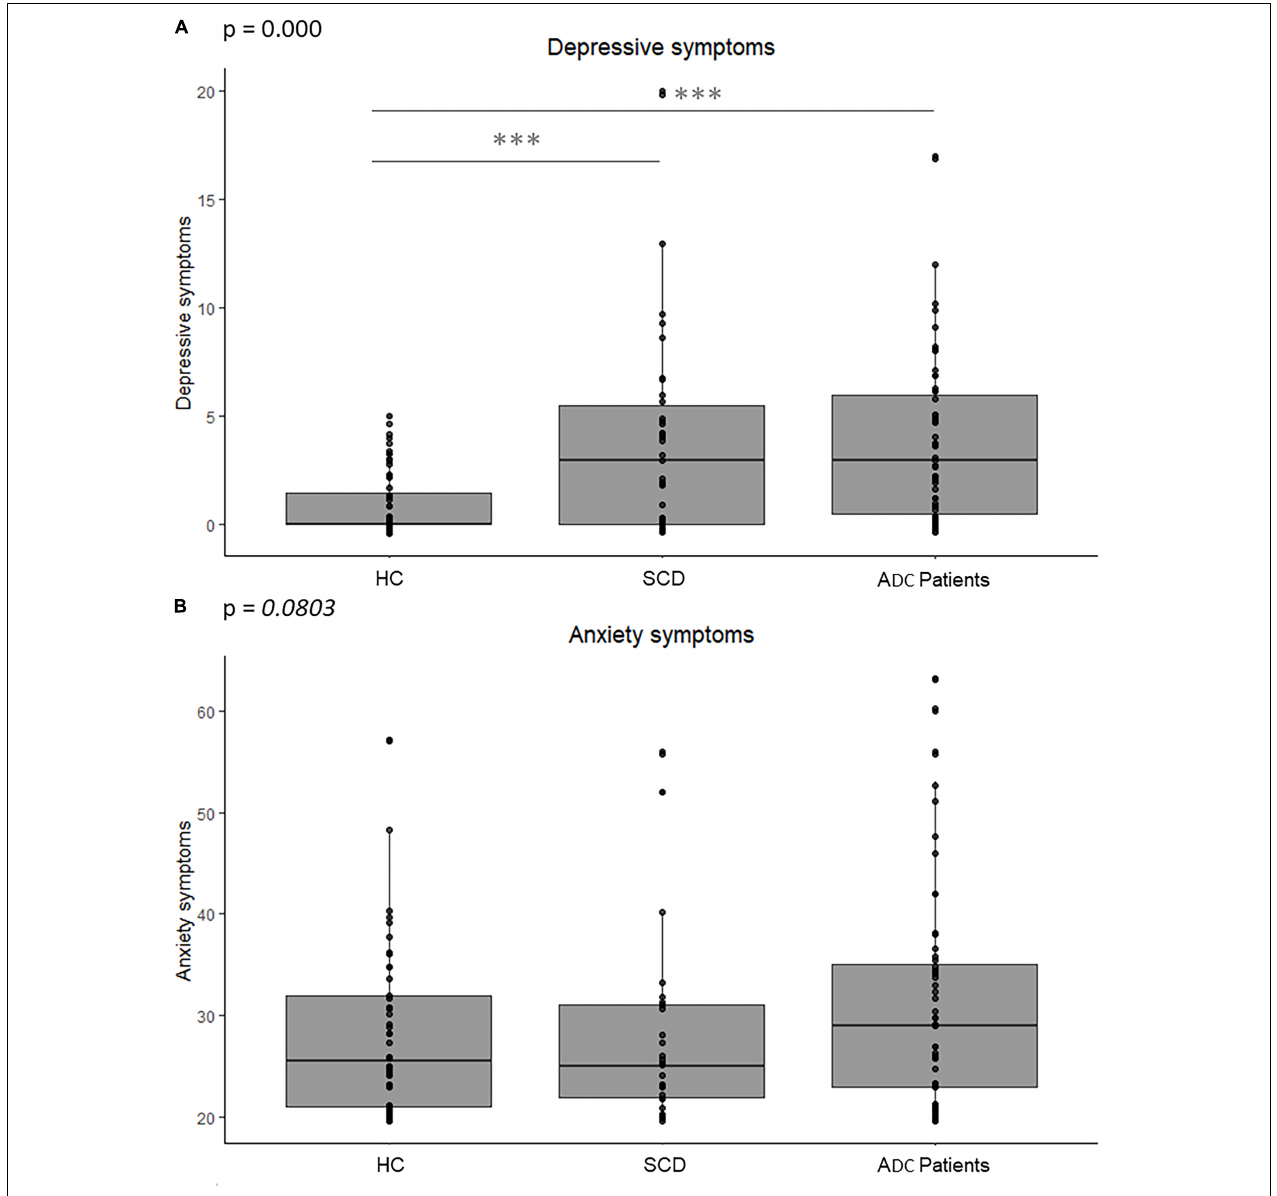
FIGURE 1 | Difference in psychoaffective factors between groups of healthy controls, SCD and ADC patients. Graphs indicate boxplots of depressive and anxiety symptoms in each group. The p value of the main effect of group, measured with ANCOVAs corrected for the level of education, age and sex, is indicated on the graph. Significant post hoc results between each group are indicated with stars, ***corresponding to p values ( p < 0.001). (A) ANCOVA on depressive symptoms. (B) ANCOVA on anxiety symptoms. ADC, Alzheimer’s continuum; ANCOVA, analysis of covariance; HC, healthy controls; p, p -value; SCD, subjective cognitive